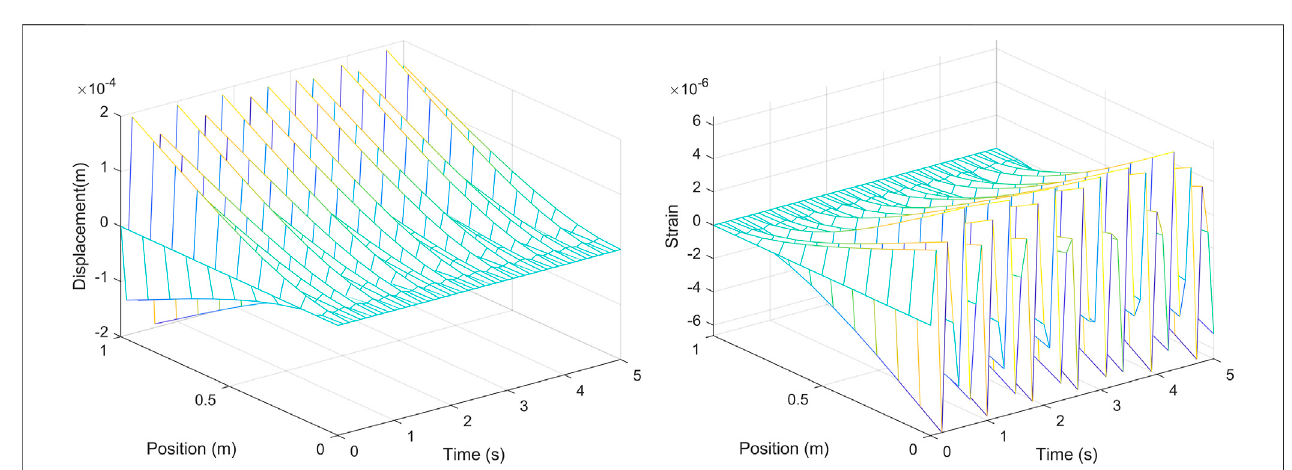
FIGURE 3 | Space – time distribution of displacements and strains of